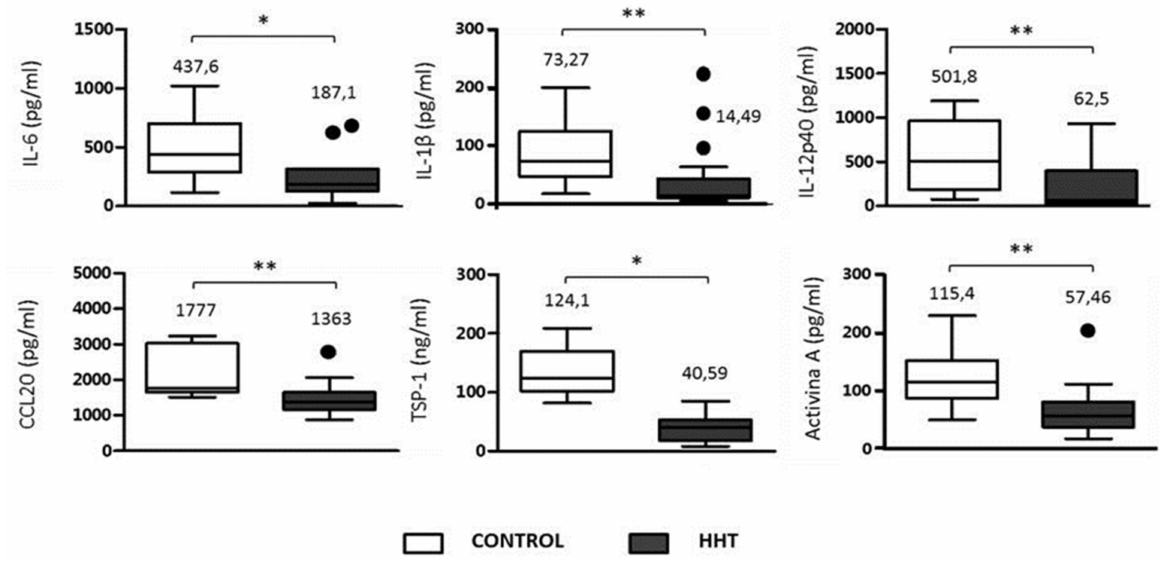
Figure 2. Inflammatory cytokines’ analysis in culture media of macrophages, isolated from HHT and control donors. A total of 500,000 mononuclear cells from healthy and HHT donors were cultivated in DMEM with 10% of FCS, and treated by 10 ng/mL of LPS for 48 h. The production of cytokines/chemokines was measured by the corresponding ELISA kits, as described in Materials and Methods. * p < 0.05; ** p <